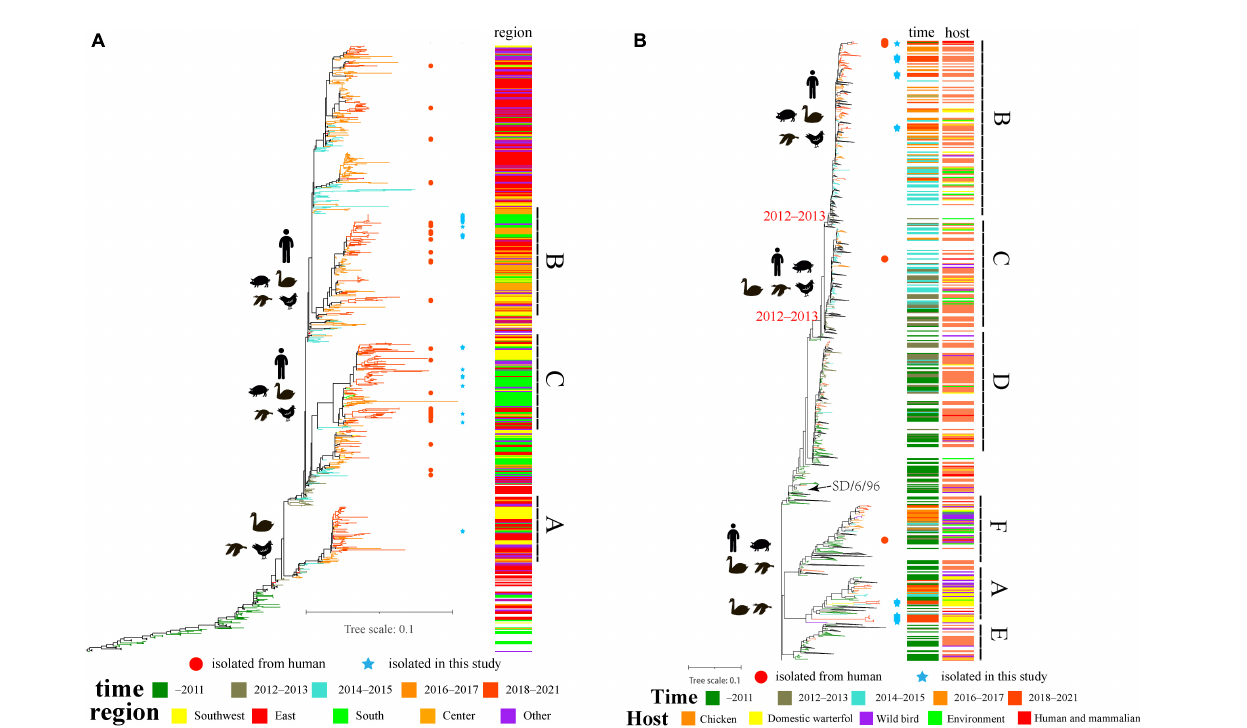
FIGURE2 The evolutionary history of H9N2 viruses in China: (A) ML tree of the HA gene of H9N2 viruses; (B) ML tree of NA gene of H9N2 viruses. Different years, regions and hosts are denoted by different symbols. All branch lengths are scaled according to the numbers of substitutions per site. The tree is rooted using A/chicken/Beijing/1/1994/H9N2. The blue pentagrams represent isolates in this study; the red circles represent human isolates that were isolated in